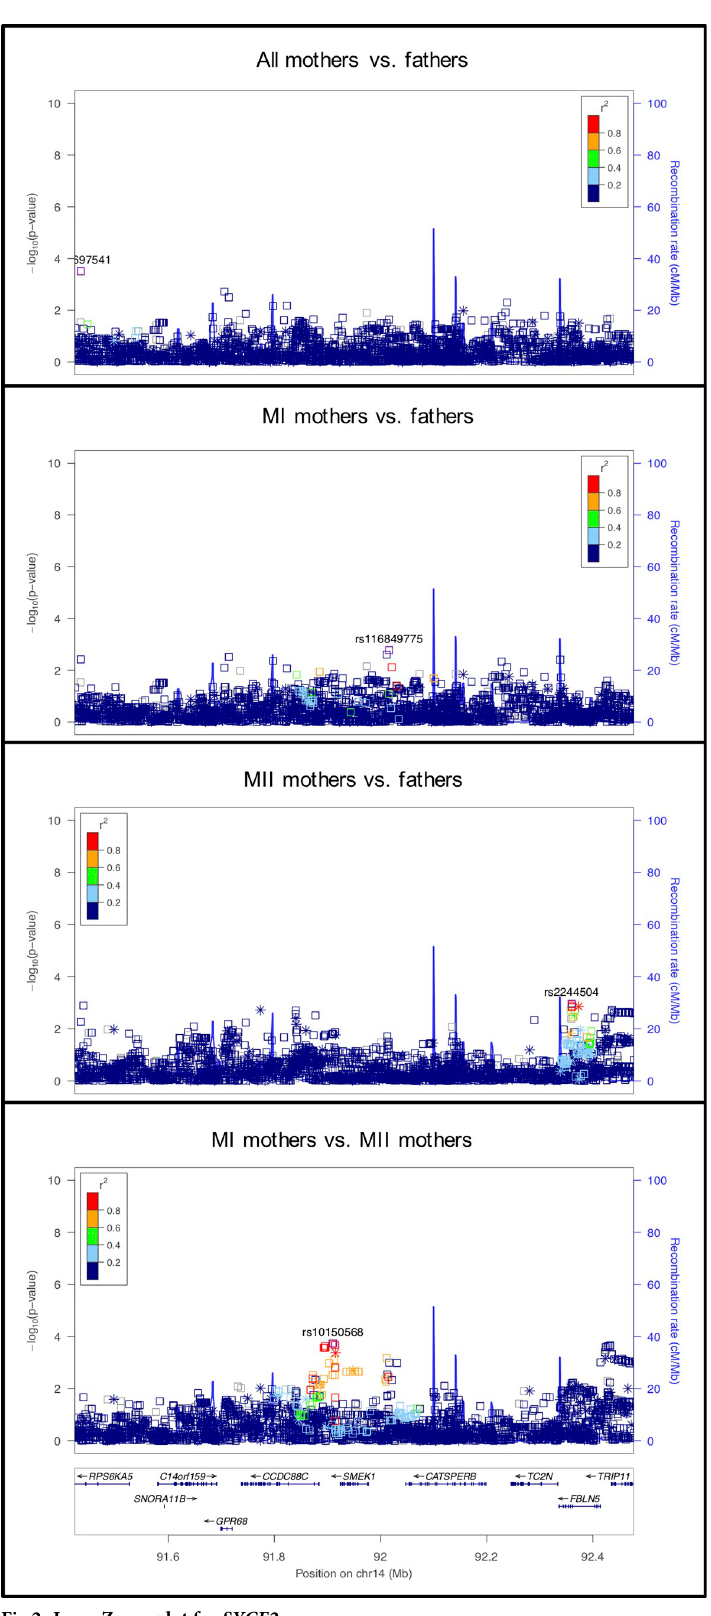
Fig 2. LocusZoom plot for SYCE2